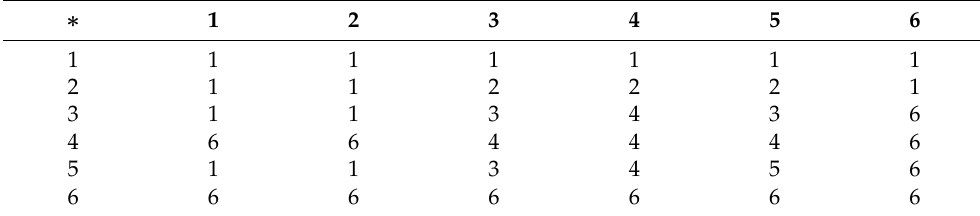
Table 9. A semigroup of Example 7.